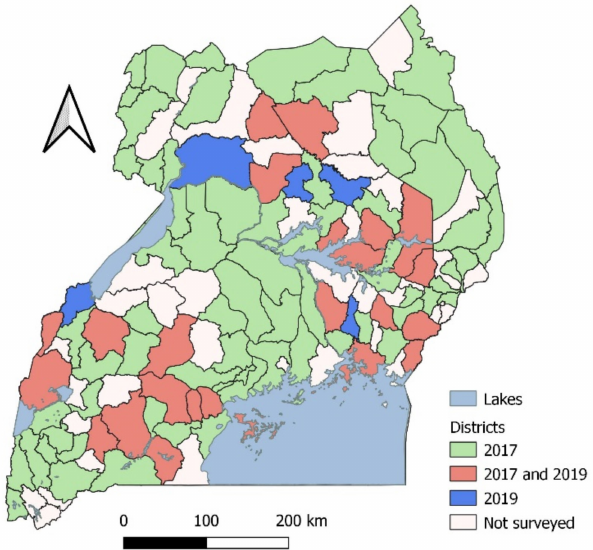
Figure 1. Map of Uganda showing districts in which surveys for fall armyworm parasitoids were conducted in 2017 (green), 2019 (dark blue), and 2017 and 2019 (red). Districts not surveyed have been left